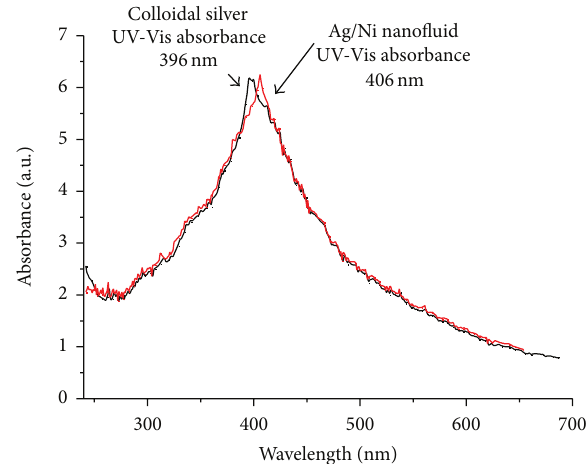
Figure 7: UV-Vis absorption spectra of colloidal silver and Ni/Ag